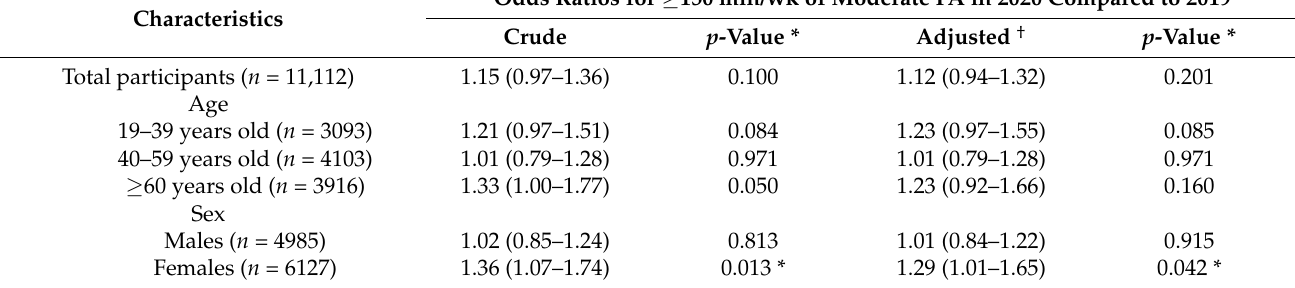
Table 3. Odds ratios (95% confidence intervals) for ≥ 150 min/wk of moderate-intensity physical activity in 2020 compared to 2019 with subgroup analyses according to age and